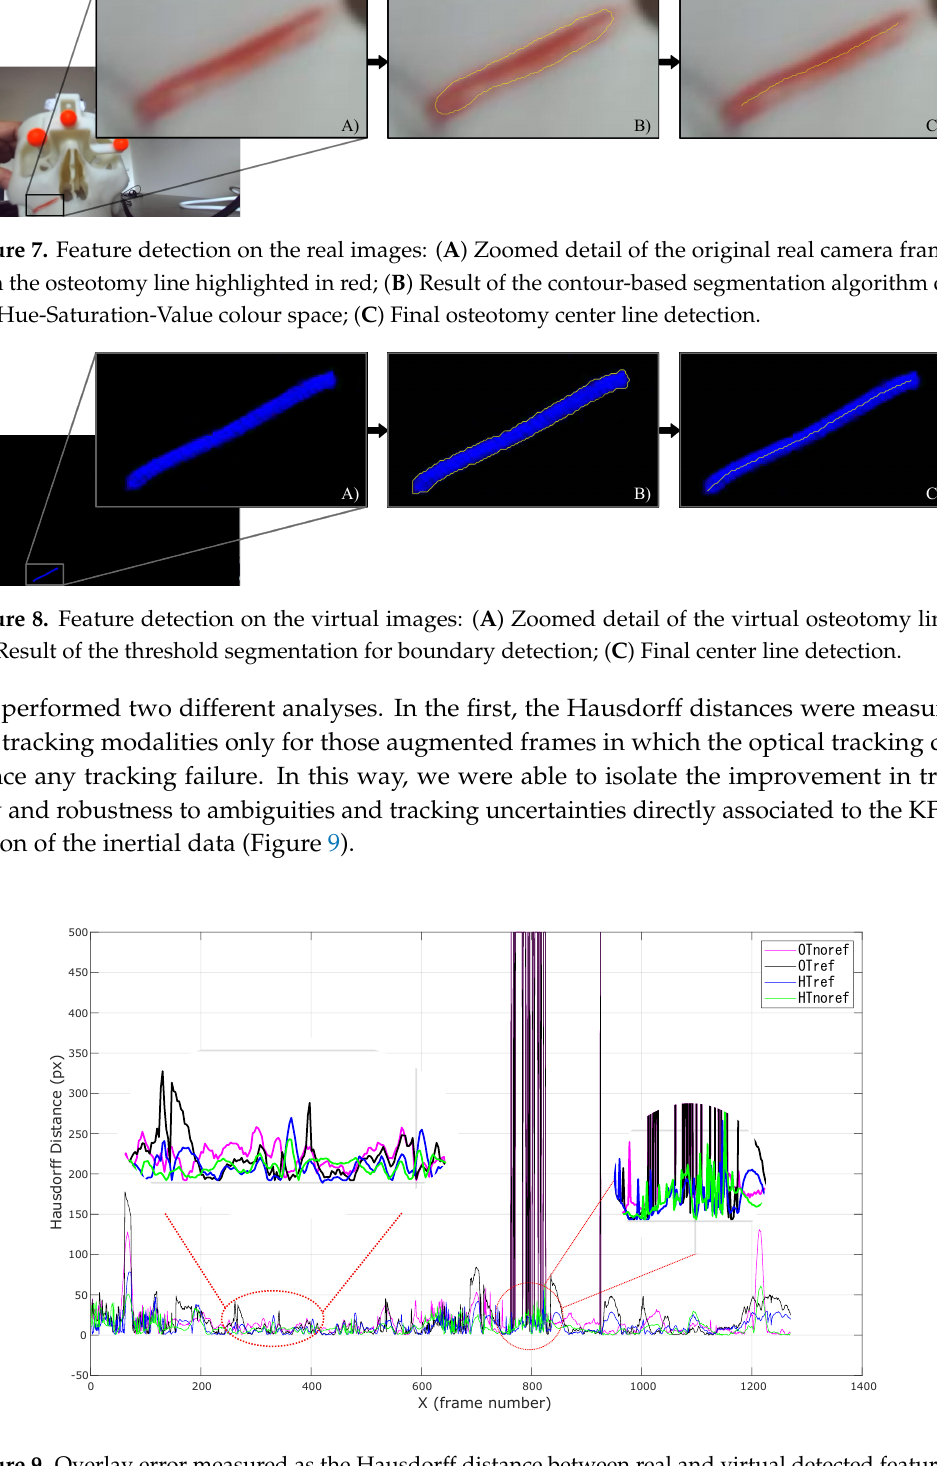
Figure 9. Overlay error measured as the Hausdorff distance between real and virtual detected features. For a better result display, only the first 1250 frames of the dynamic test are shown. The first zoomed circle on the left depicts how the Kalman filter (KF)-based heterogeneous tracking reduces the overlay error by improving the accuracy and robustness to ambiguities and tracking uncertainties. The second zoomed circle shows how the KF-based heterogeneous tracking is capable to tackle short-to-middle term optical tracking